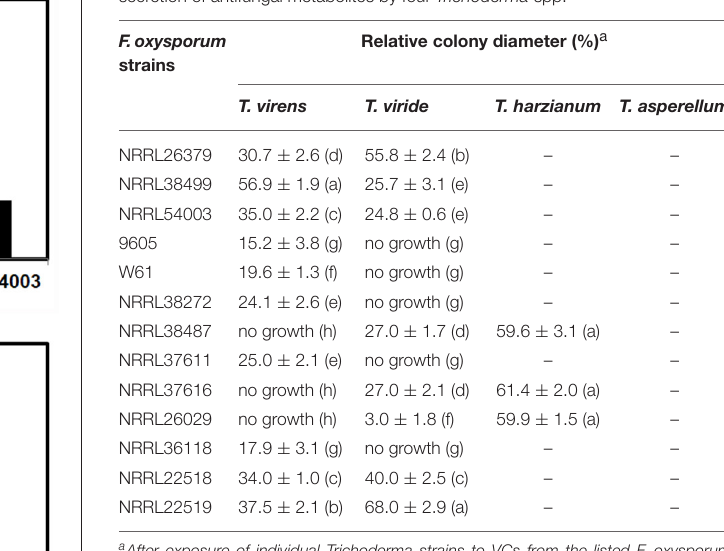
TABLE 4 | Effect of VCs produced by diverse F. oxysporum strains on the secretion of antifungal metabolites by four Trichoderma